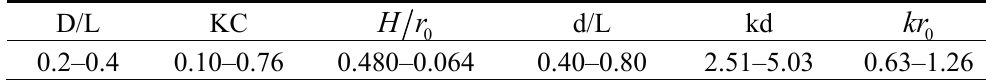
Table 1. Ranges of linear-wave characteristic